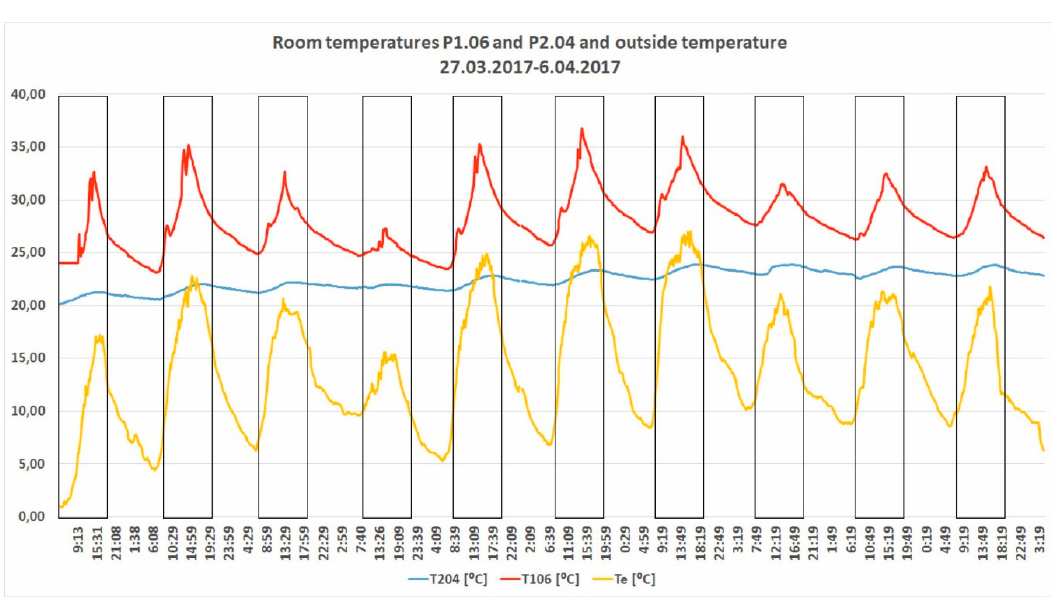
Figure 13. Wavelength of indoor air temperature changes in room P2.04 ( T i ) and mean radiation temperature (TR).